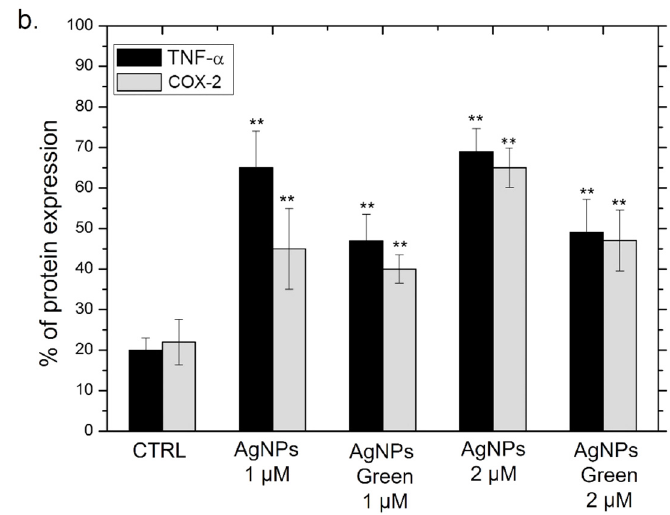
Figure 9. Western blot ( a ) and densitometric analysis ( b ) of TNF- α and COX-2 expression on THP-1, after 48 h of exposure to 2 µ M of conventional and green Ag NPs. The reported data are estimated as an average of five independent experiments ± SD and they are considered statistically significant with p -value < 0.01 (<0.01 **). Table 2. IC50 values calculated on data measured by viability assays reported in Figure